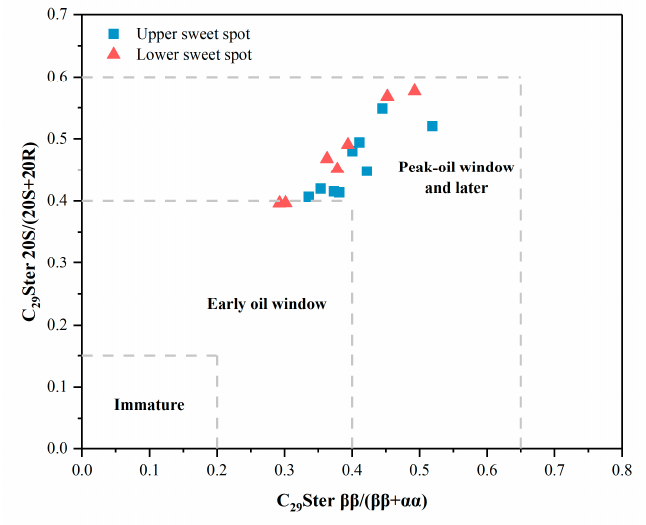
Figure 6. Representative mass chromatograms (m/z 217) showing the sterane distribution of saturated hydrocarbon fraction samples from the ( a ) upper sweet spot; and ( b ) lower sweet spot.